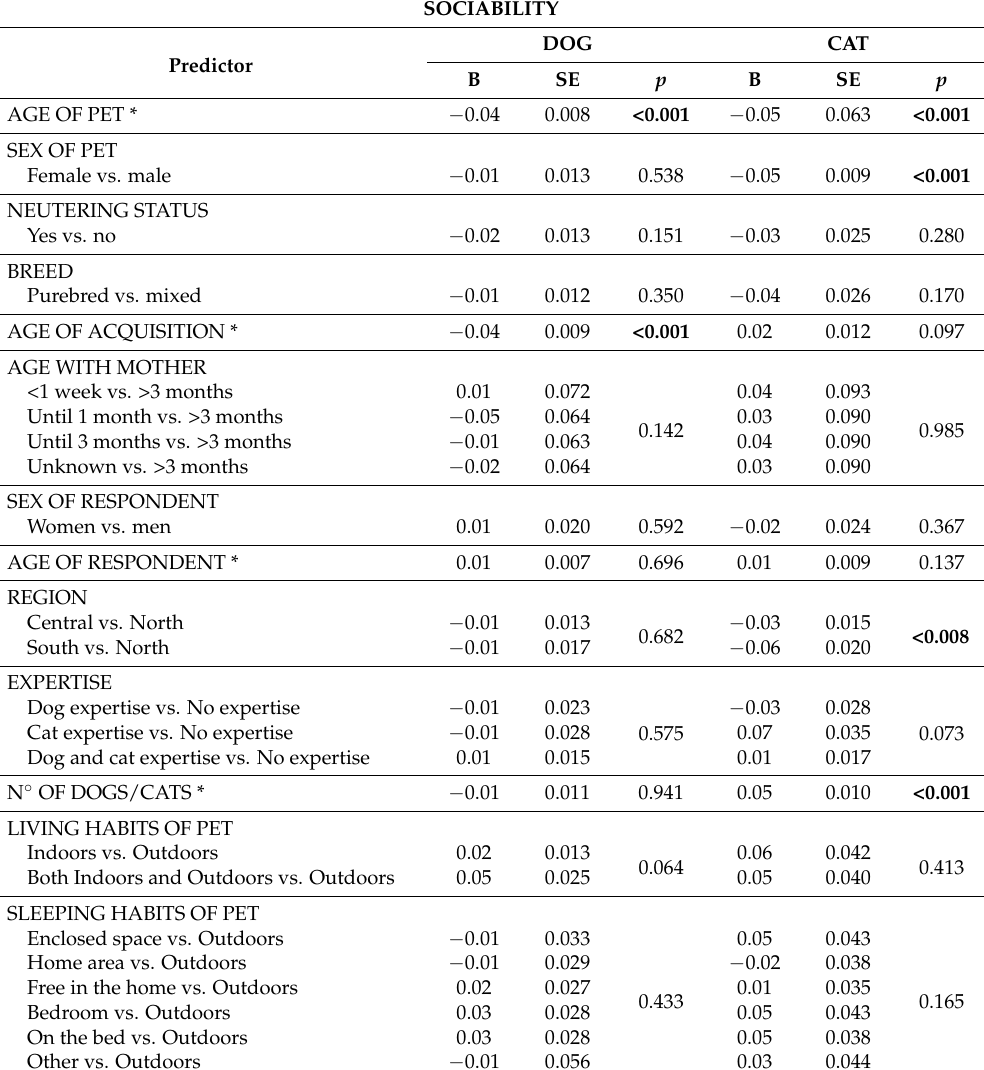
Table 2. Multivariate regression analysis for sociability in dogs and cats living in the same